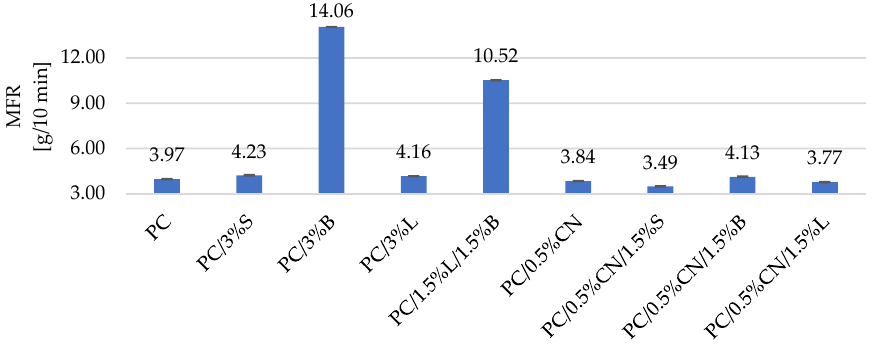
Figure 4. Summary of the obtained mass flow rate (MFR) results. PC—polycarbonate, S—modified silica, B—modified bentonite, L—lignin/SiO 2 hybrid, CN—multiwalled carbon nanotubes.